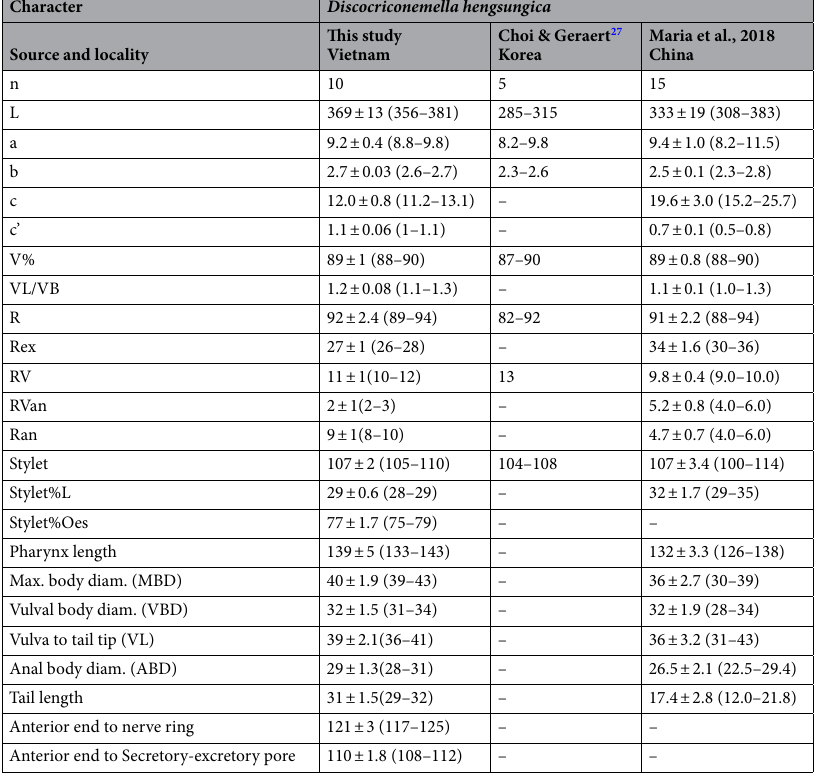
Table 2. Morphometrics of Discocriconemella hengsungica from Vietnam and the world. Measurements are in μm and in the form: mean ± s.d.